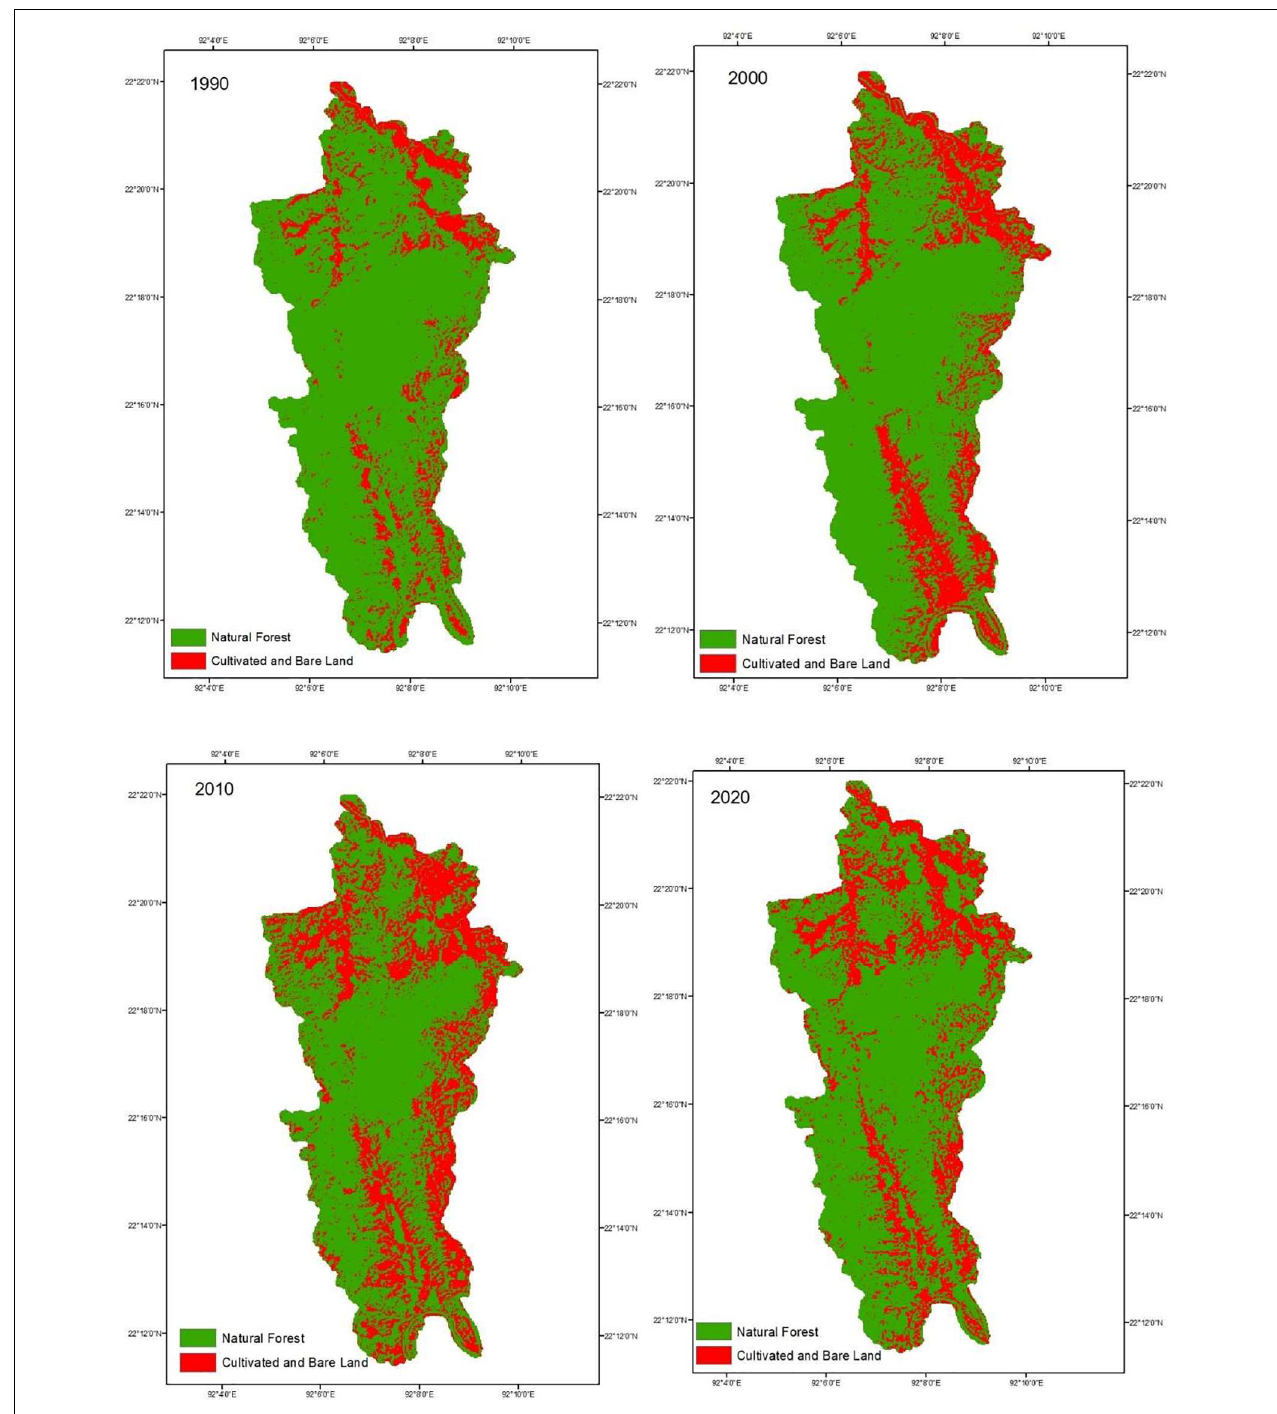
FIGURE 2 | Forest cover changes in DDWS since 1990 to 2020.